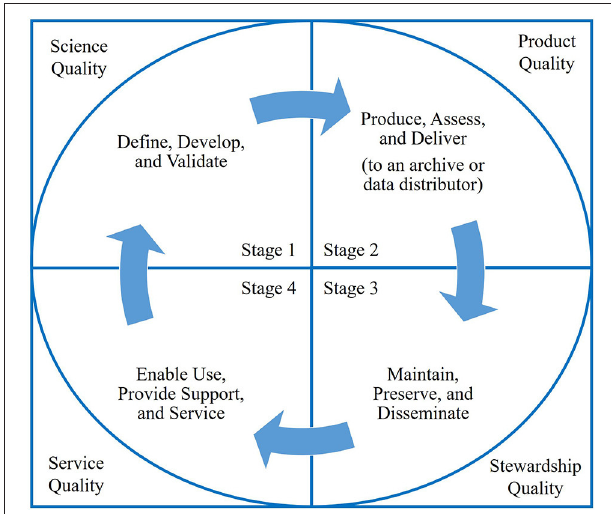
FIGURE 1 | Information quality dimensions and data lifecycle